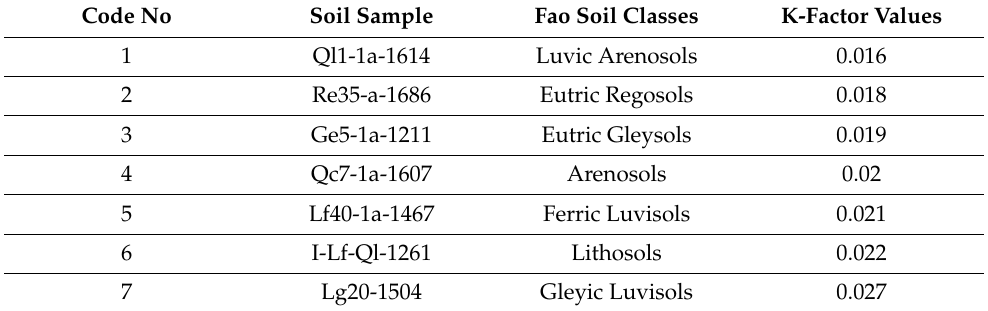
Table 2. K-factor value for soil